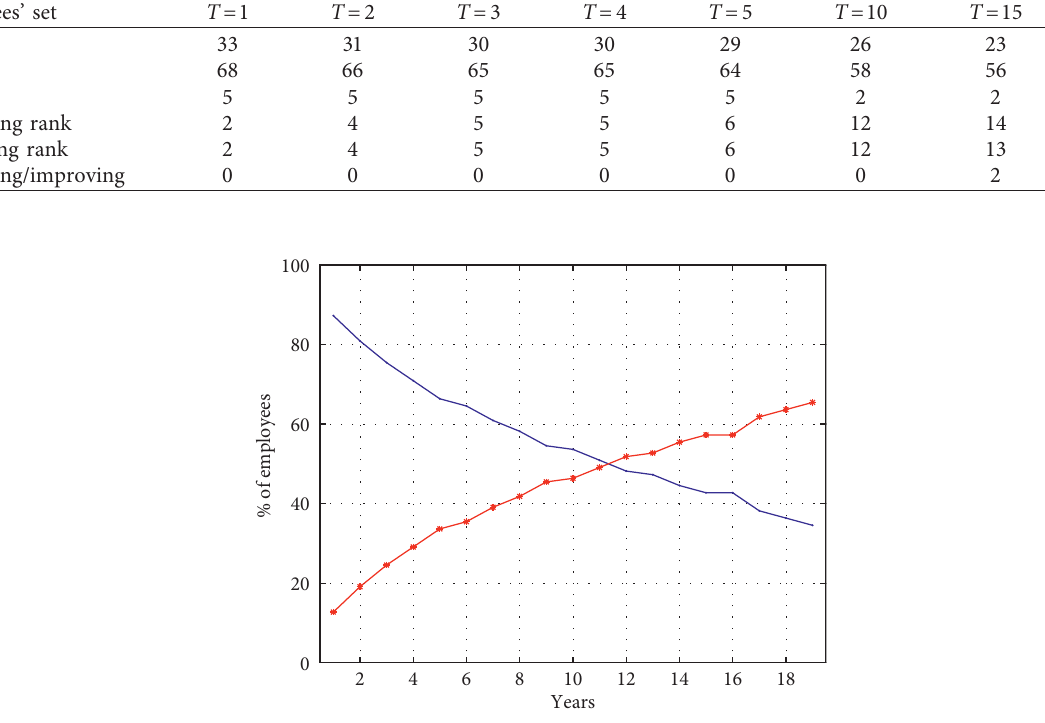
Figure 9: Percentage of employees for which the incentives’ mechanism works in red star line and does not work in blue circle